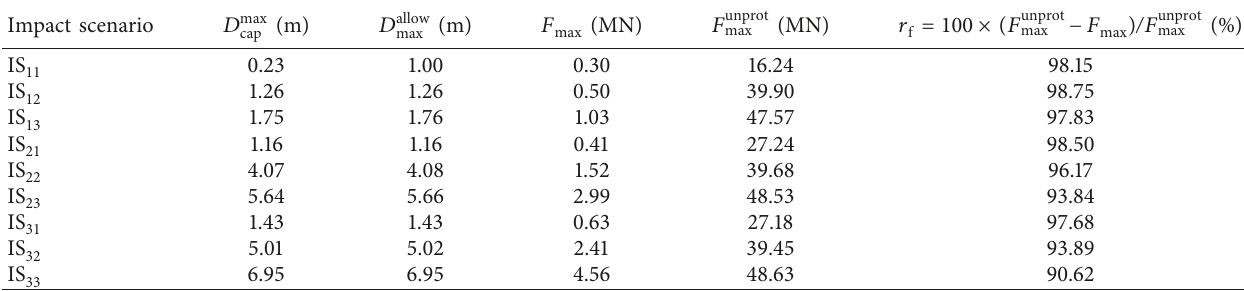
Table 6: Maximum cap displacements and maximum impact forces on the pier using or without using optimum devices corresponding to different impact